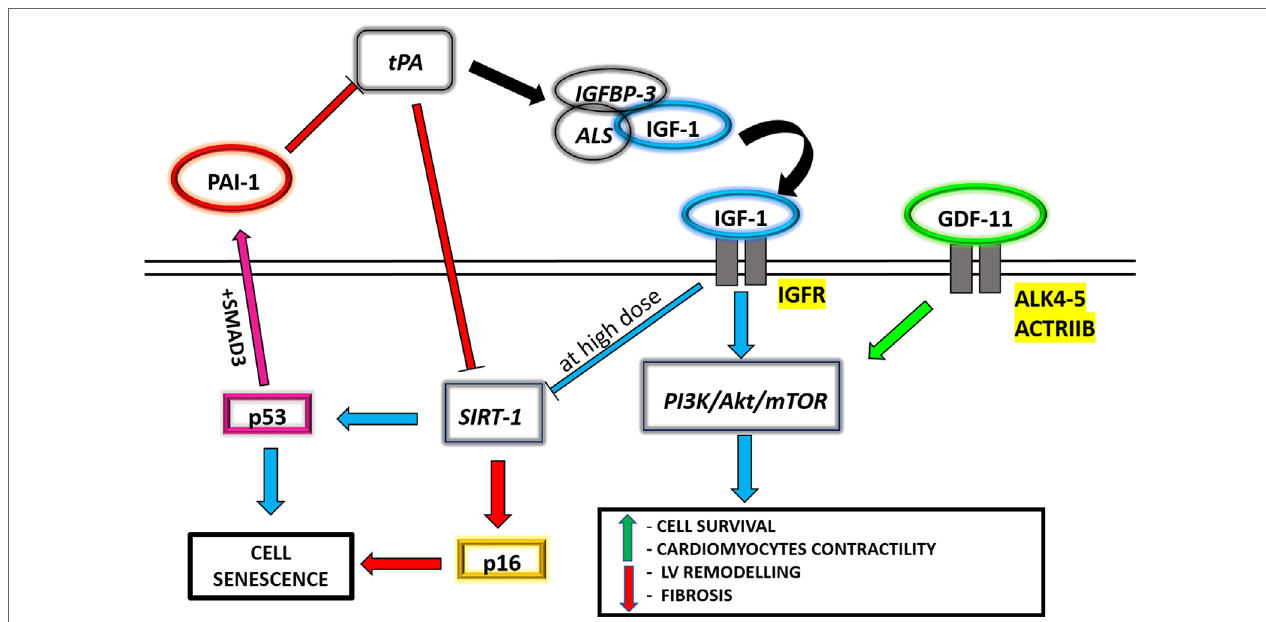
FiGURe 1 | A schematic panel of the circulating molecules analyzed in the text, aiming at underlining the connections between their different related